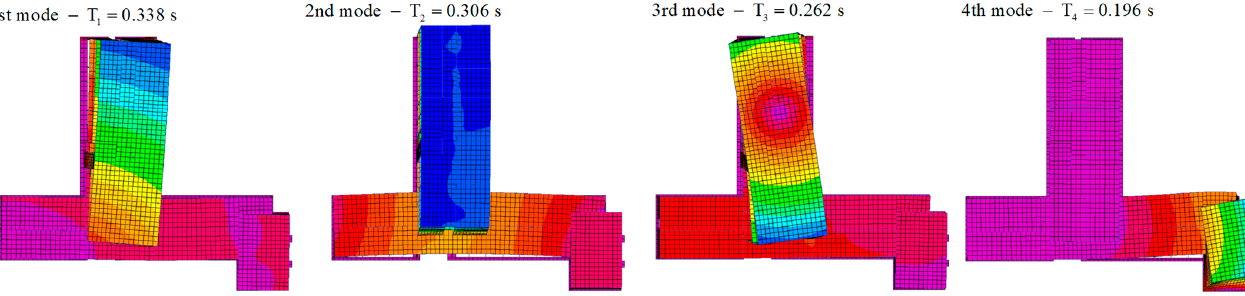
Figure 13. Eigenmodes and corresponding periods values for the as-built state of the building.